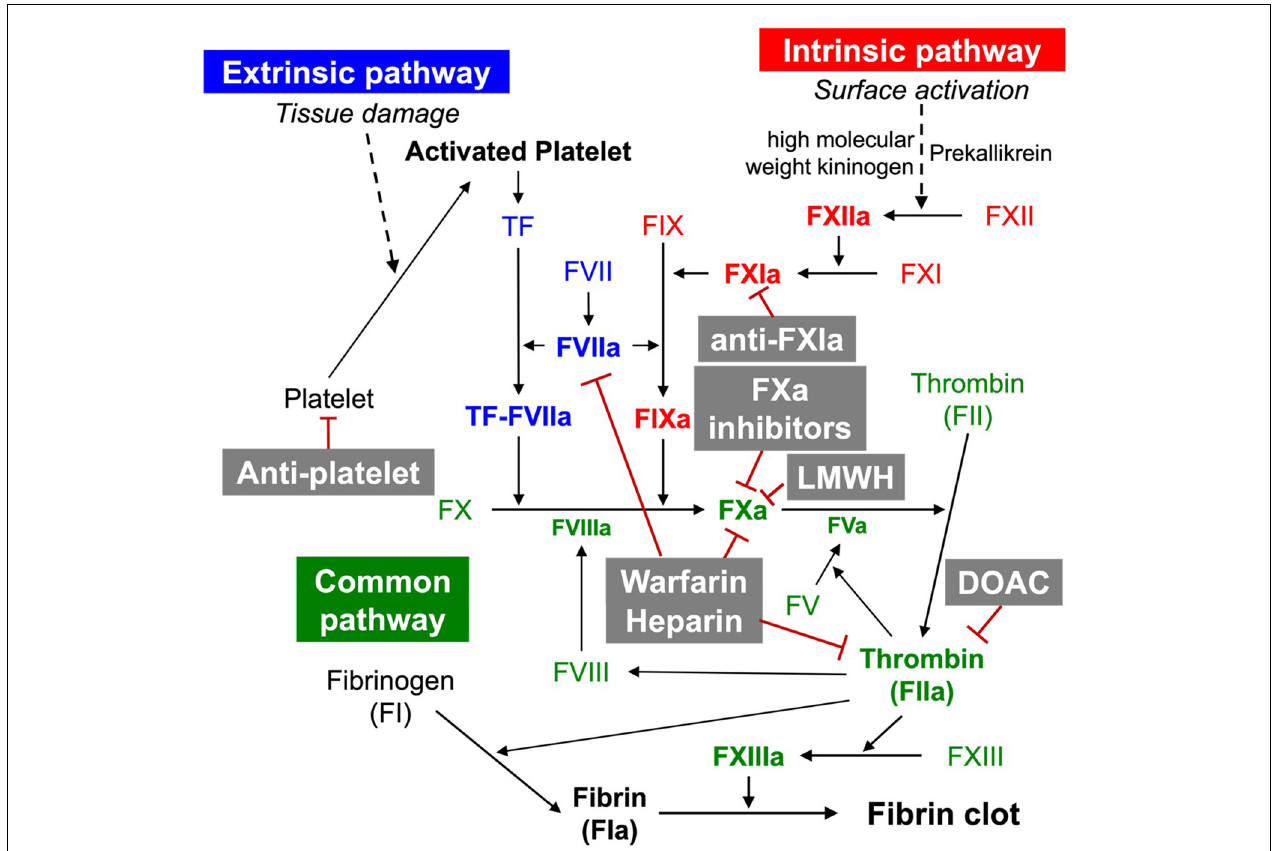
FIGURE 1 | Coagulation cascade and